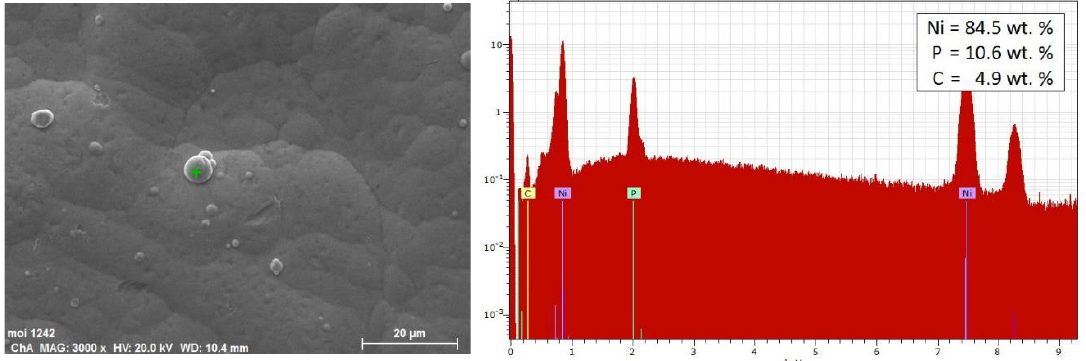
Figure 6. EDS analysis of the single nodule at the surface of the heat-treated electroless Ni coating with embedded c-BH nanoparticles (Ni-BN HT ).